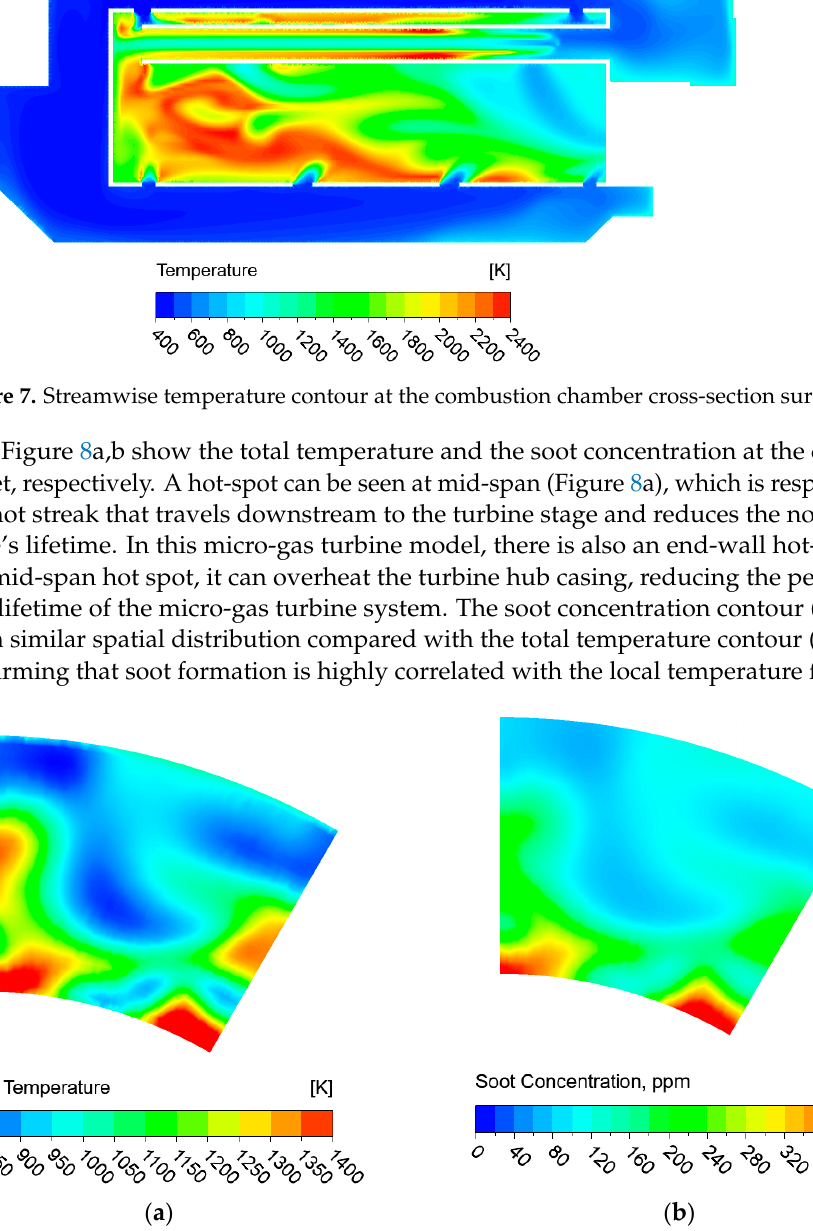
Figure 8. Combustor outlet contours: ( a ) total temperature; ( b ) soot concentration.